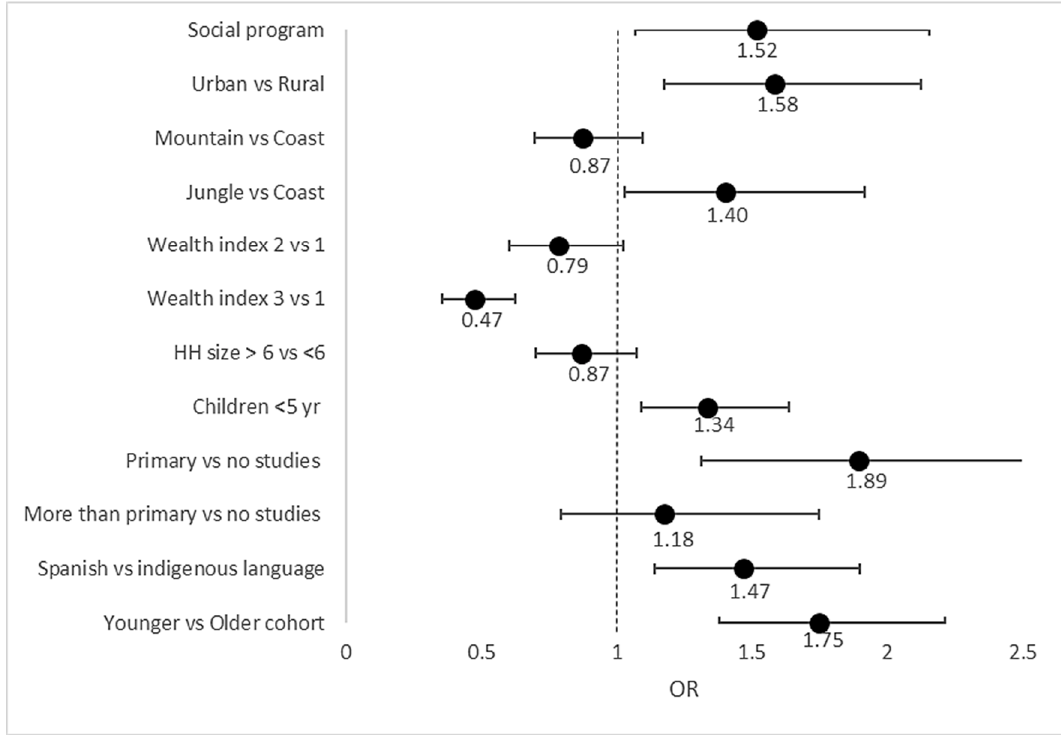
Figure 2. Household vulnerability characteristics associated with Bonos during COVID-19 from logistic multivariate regression model. Forest plot showing the household vulnerability characteristics associated with receiving any type of Bonos. The estimates are based on a multivariate logistic regression model. The values represent the estimated odd ratio (OR) for each characteristic, and the horizontal lines (whiskers) at both sides represents the 95% confidence interval of the OR. The vertical line represents the OR of 1 that indicates no association of the characteristic with the probability of receiving Bonos.